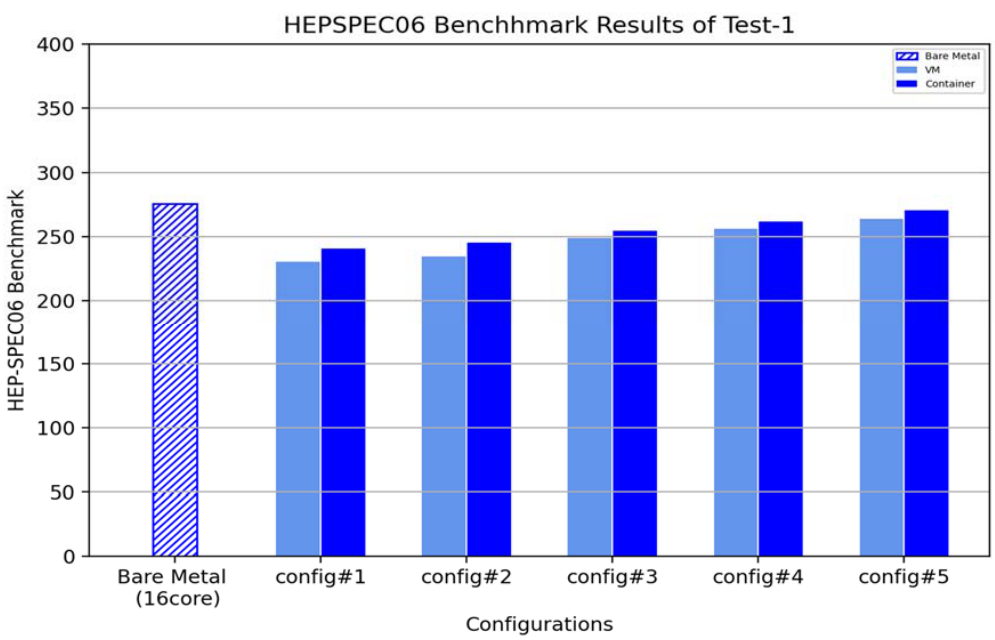
Figure 2. HEPSPEC06 benchmark results for five configurations of test ‐ 1.